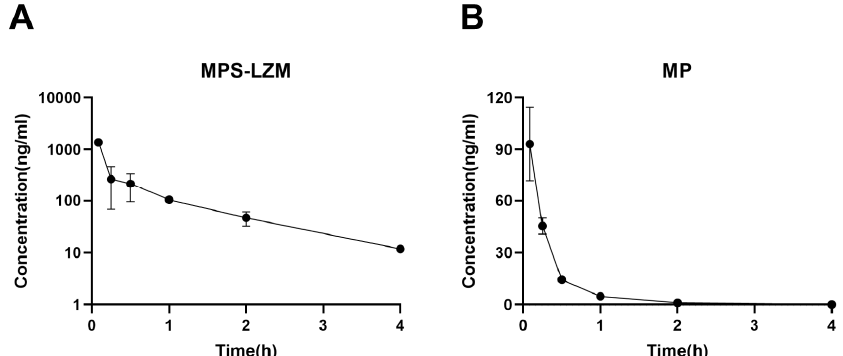
Figure 6. Plasma disappearance of ( A ) MPS–LZM and ( B ) MP after intravenous administration. Data represent mean ± SD ( n = 6). Table 1. Pharmacokinetic parameters of MP and MPS–LZM in plasma after a single intravenous injection.